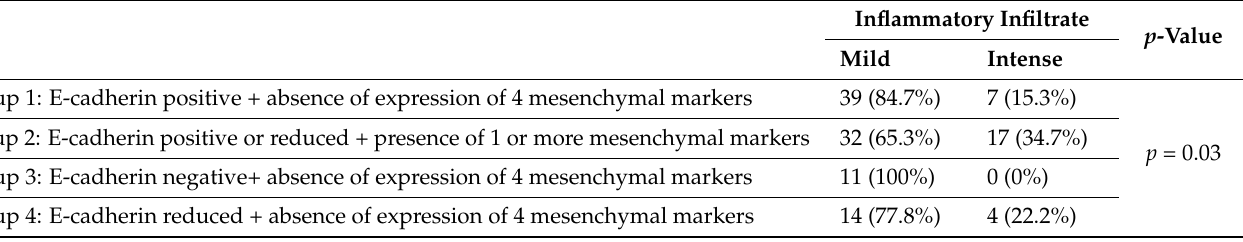
Inflammatory Infiltrate p -Value Mild Intense